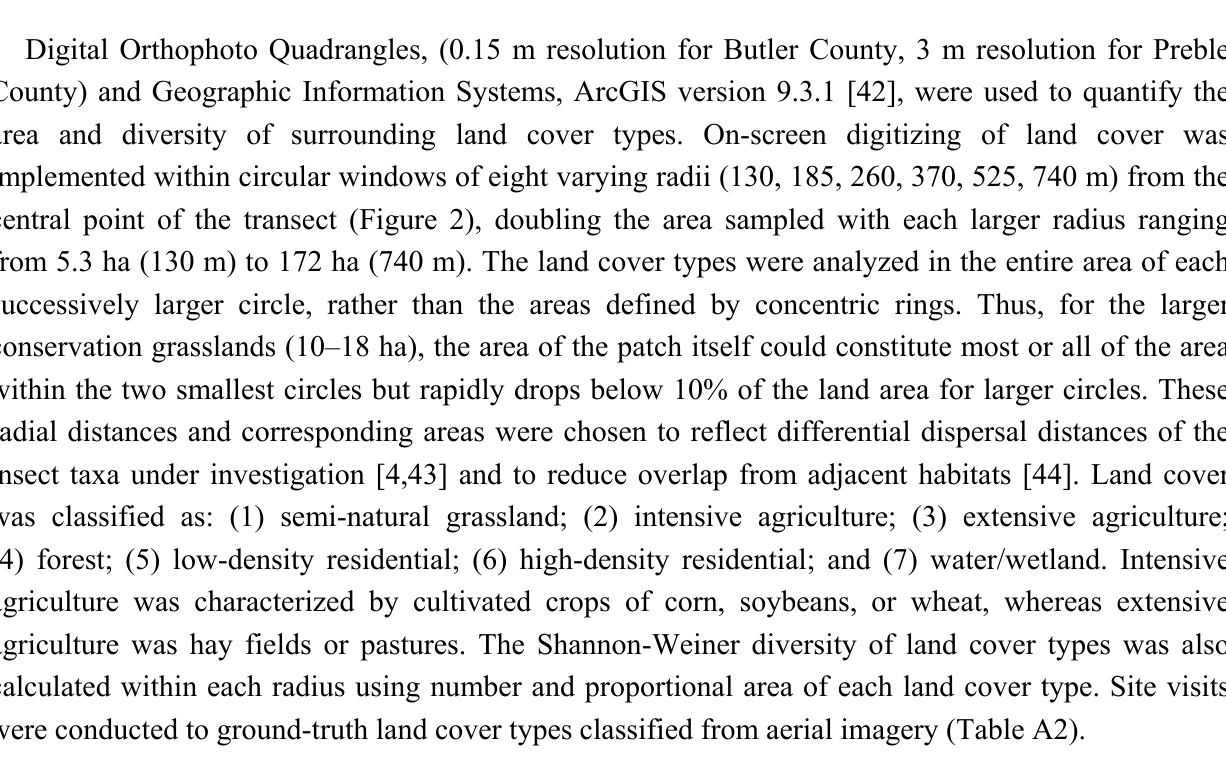
Figure 2. Methods used to quantify land cover types around conservation